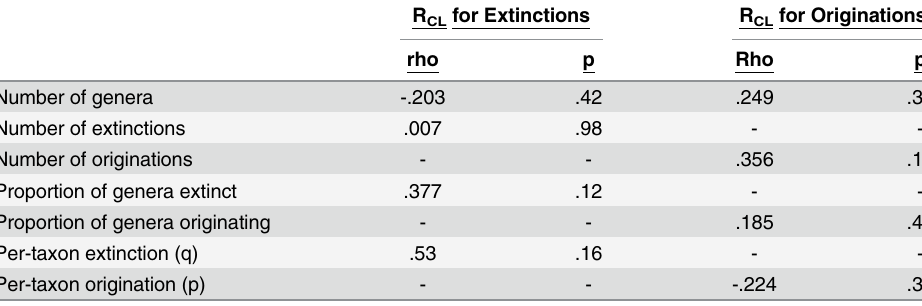
Table 1. Lack of correlation between RCL and various diversity and turnover metrics. All correlations done using Spearman rank-order correlations. Results consistent regardless of test